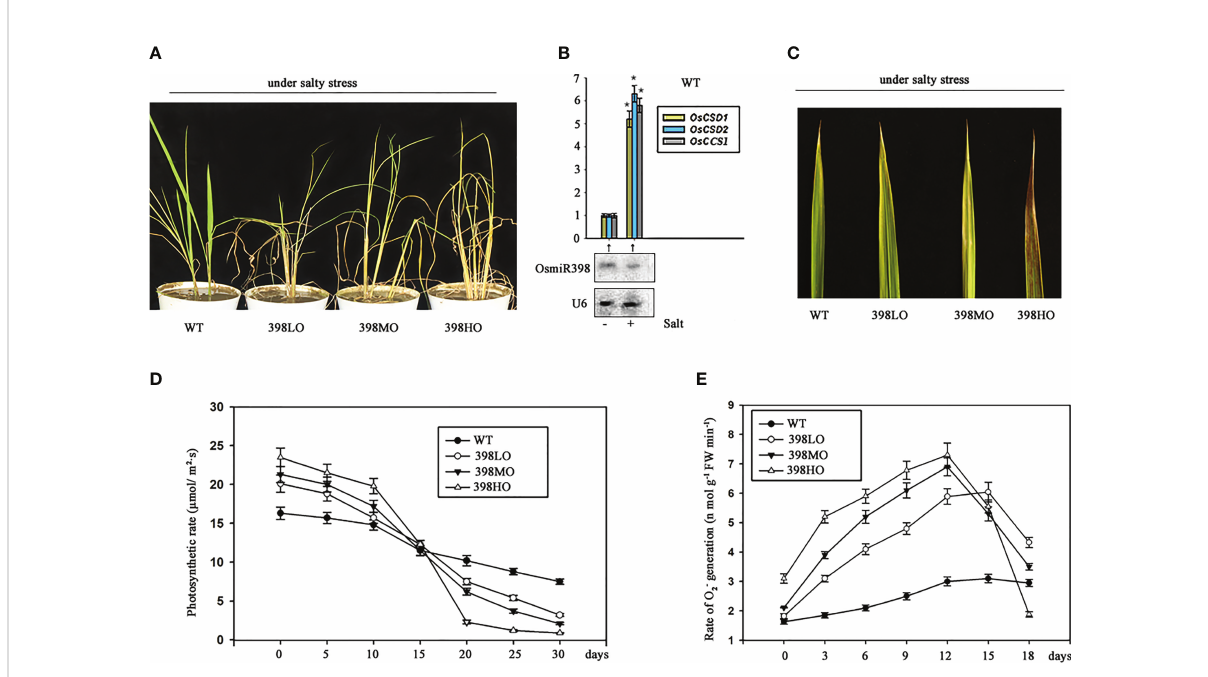
FIGURE 2 The agronomic performances of different levels of over-expressions of miR398 in rice under salt stress. (A) . Morphologies of the three transgenic lines overexpressing miR398 under mild salt stress after one month of treatment. (B) . The responses of miR398 and its three targets to salt stress in the wild type. The expression of miR398 was detected by northern blot and the expressions of its targets were measured by qRT-PCR after two days of treatment. “ - ” means no salty stress and “ + ” means imposed salt stress. U6 served as loading control for small RNA. Asterisks indicate signi fi cant difference at P ≤ 0.05 compared with the no salt stress by Student ’ s t test (n = 3; means ± SD). (C) . Phenotypes of the upmost leaf of the WT, 398LO, 398MO, and 398HO lines after 3 weeks of treatment. (D) . Time course of photosynthetic rate in the wild- type, 398LO, 398MO, and 398HO lines under salt stress. The photosynthetic rates were measured by detecting CO 2 exchanging rate after being transplanted into salty soil. (E) . Changes of cellular O 2 – generation rates in the wild-type, 398LO, 398MO, and 398HO lines under salt stress. All data was the means of three independent measurements ± s.e. in Figure D and